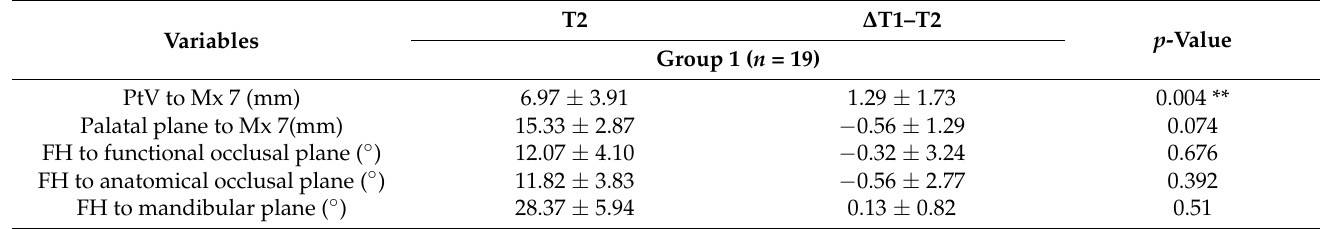
Table 4. Comparison of the skeletal and dental changes during the treatment